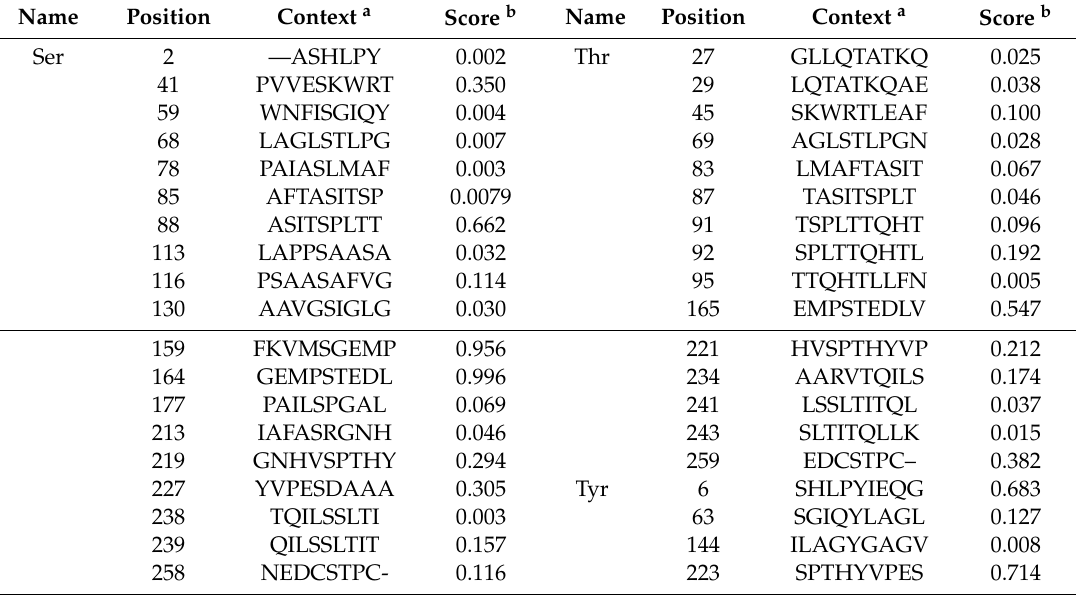
Table 1. Predicted phosphorylation sites in As